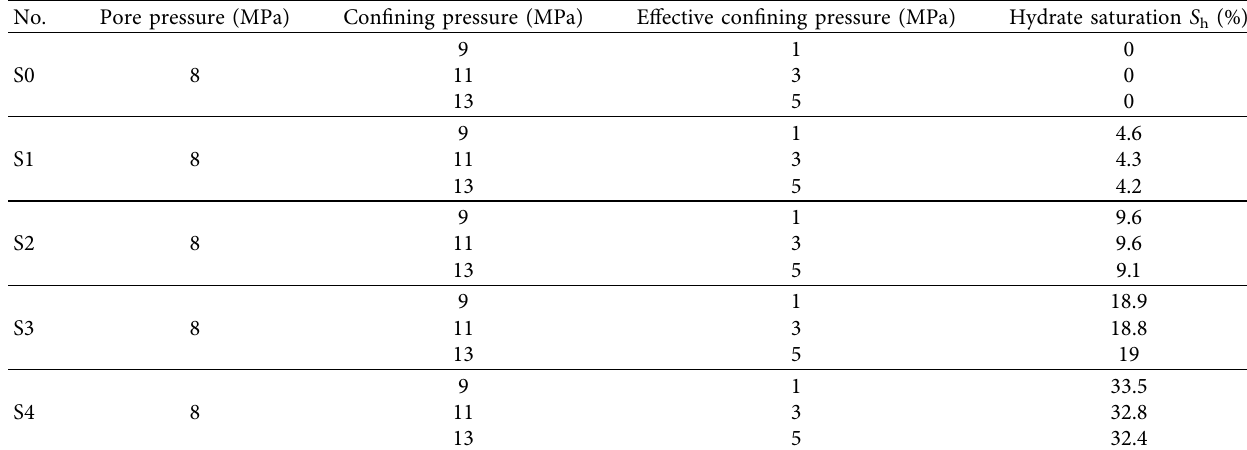
Table 1: The test conditions for HBS